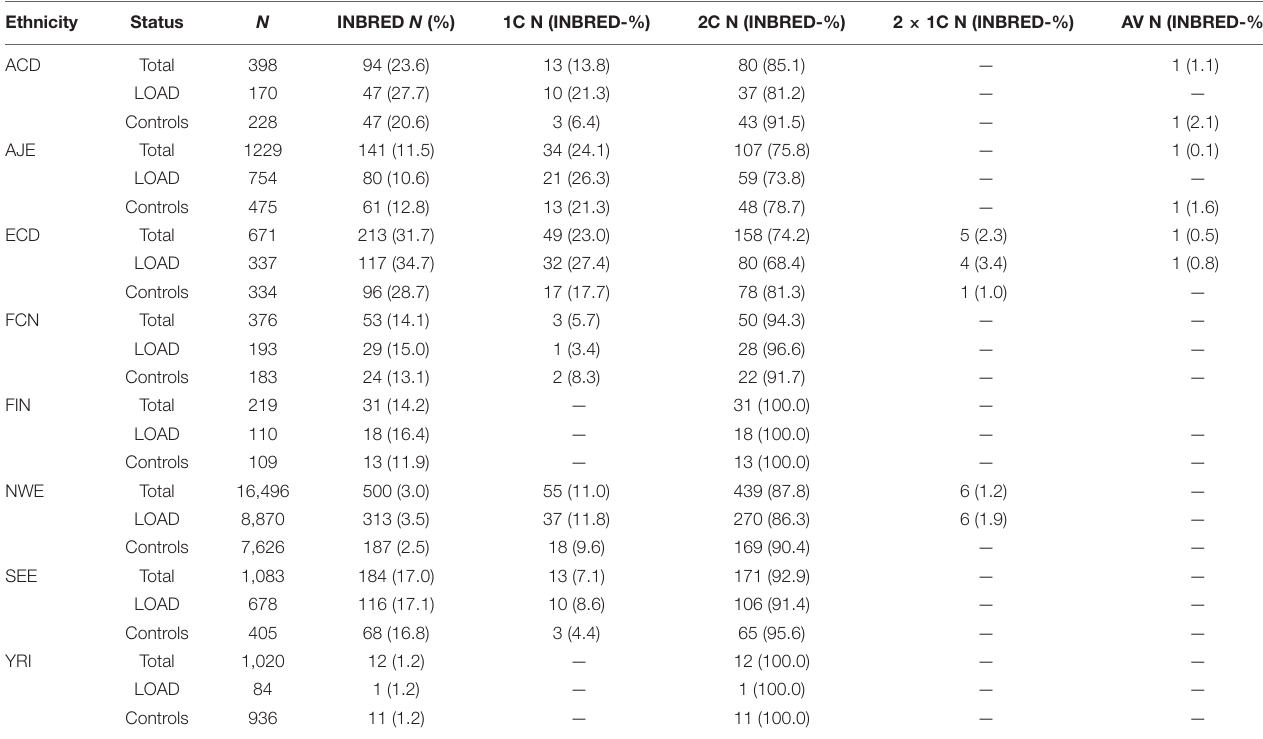
TABLE 1 | Consanguinity rates differ across the eight ethnic groups analyzed.